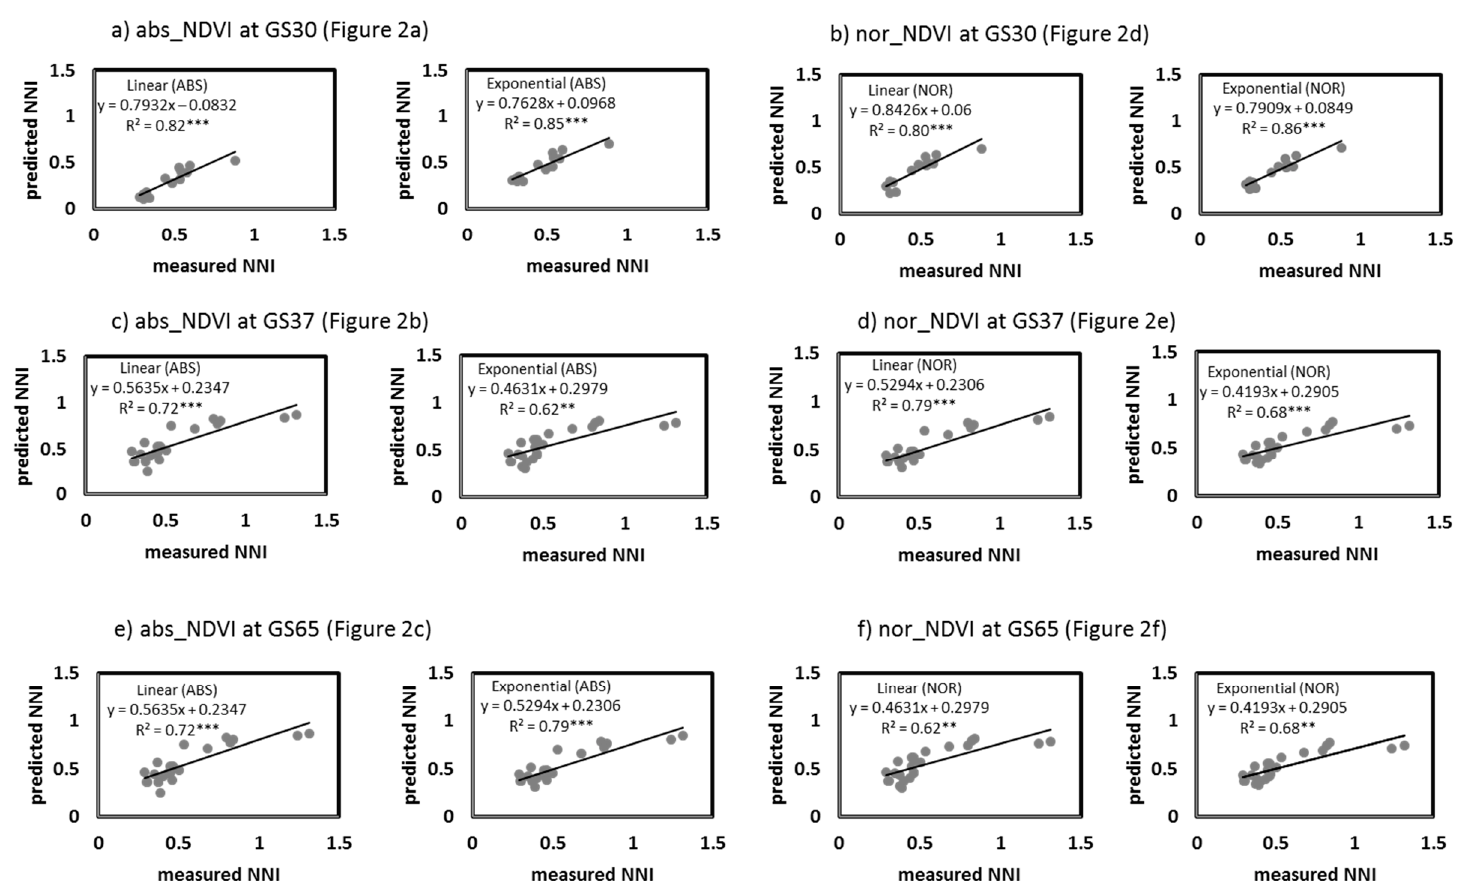
Figure 7. Relationships between the predicted NNI (Nitrogen Nutritional Index) values (from abs_NDVI at GS30 ( a ), nor_NDVI at GS30 ( b ), abs_NDVI at GS37( c ), nor_NDVI at GS37 ( d ), abs_NDVI at GS65 ( e ) and nor_NDVI at GS65 ( f ) values in the growing stage-specific models) and the measured NNI values from 25% of the samples. **, *** Significant at 0.01 and 0.001 probability levels, respectively. abs, absolute values; nor, normalized values; NDVI, Normalized Difference Vegetation Index.